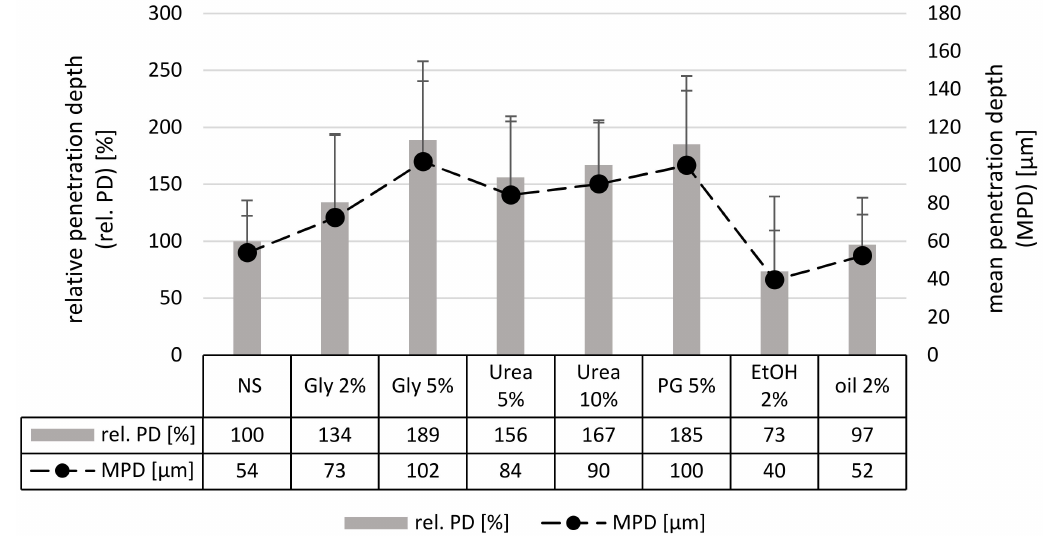
Figure 3. Influence of excipients on the penetration depth of curcumin determined by digital image analysis. MPD = mean penetration depth [ µ m], rel. PD = relative penetration depth [%] in comparison to the penetration depth of curcumin from the nanosuspension without additives.